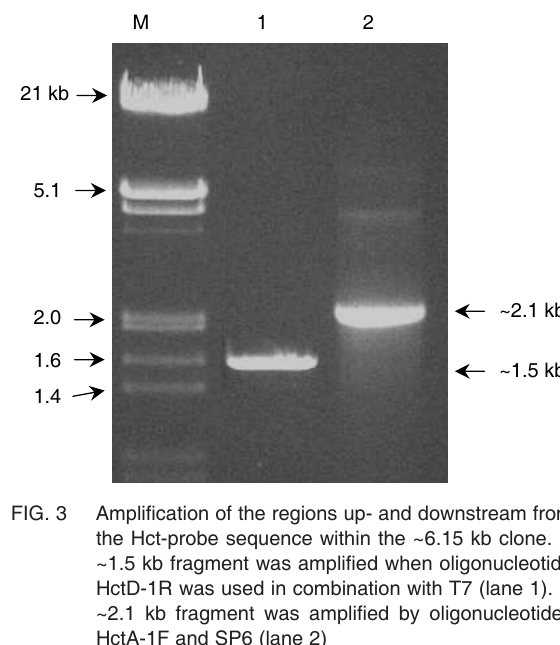
FIG. 2 Southern blot analysis of digested genomic DNA hybridised with the Hct-probe under stringent condi- tions. Genomic DNA was digested with Bam HI (lane 1), Eco RI (lane 2), Hind III (lane 3), Pst I (lane 4) and Xba I (lane 5) for 3 h. Arrow indicates positive hybridi-